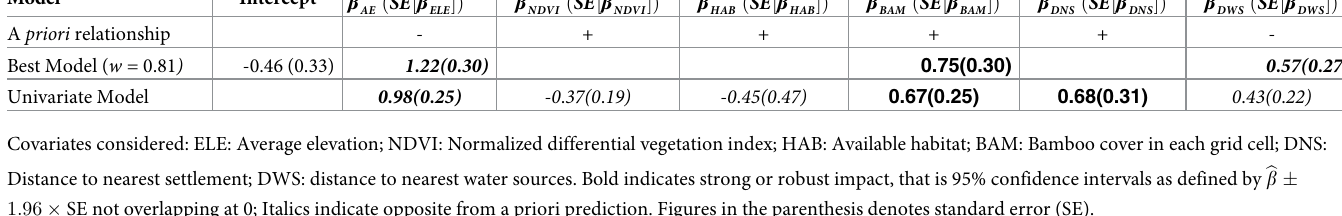
Table 4. β estimates from the logit link function based on best and univariate models for red panda occupancy probability (Psi). Model Best Model ( w = 0.81